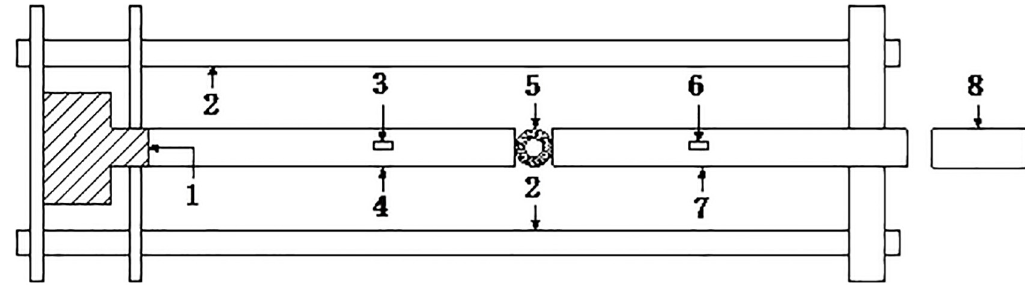
Fig 2. Impact loading diagram of the SHPB test system. 1-Amortisseur; 2-Support; 3-Strain gauge A2; 4-Transmission bar; 5-Rock specimen; 6- Strain gauge A1; 7-Incident bar; and8- Impact hammer.